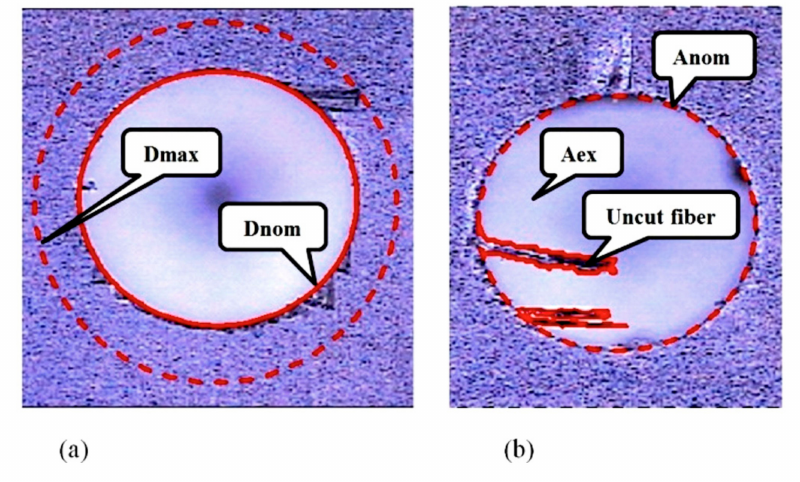
Figure 4. ( a ) The delamination and ( b ) the uncut fiber